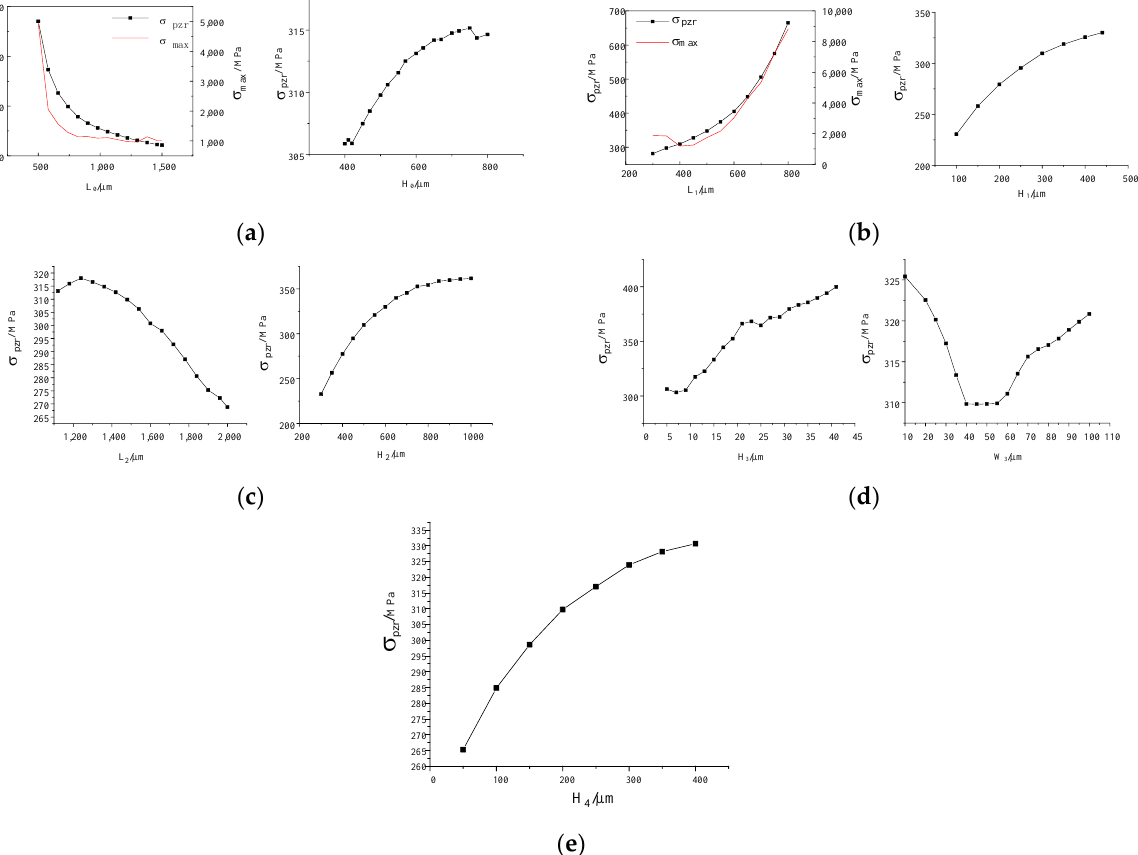
Figure 5. The relationship between structure size ( a ) L 0 , H 0 , ( b ) L 1 , H 1 , ( c ) L 2 , H 2 , ( d ) H 3 , W 3 , ( e ) H 4 and equivalent stress.